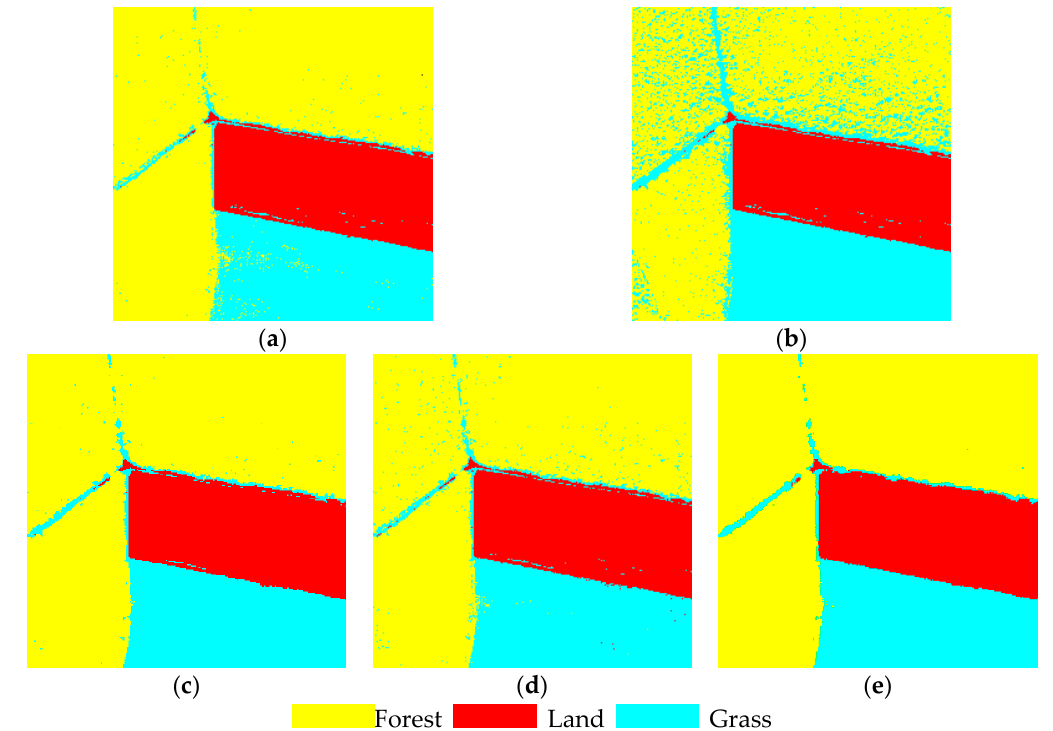
Figure 11. IKONOS image classification results. ( a ) Maximum likelihood method HMRF-FCM; ( b ) FCM; ( c ) HMRF-FCM; ( d ) Weighted average method; and, ( e ) Neighborhood weighted average.